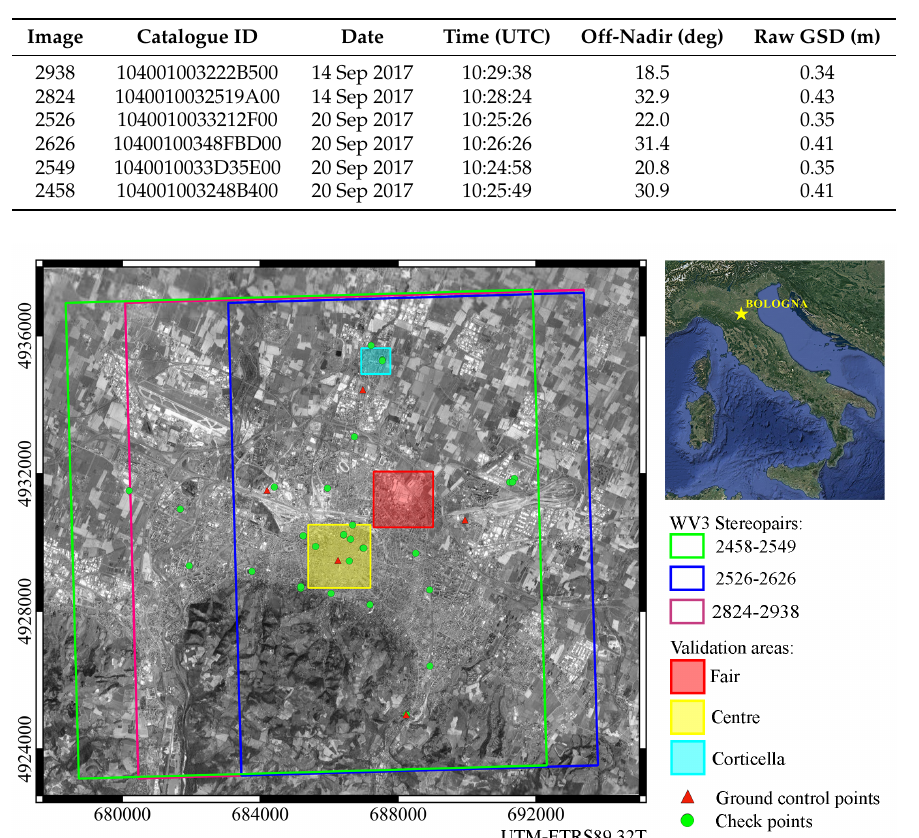
Figure 1. Location of the study area with the footprints of the WV3 pairs, the validation areas and control and check points.